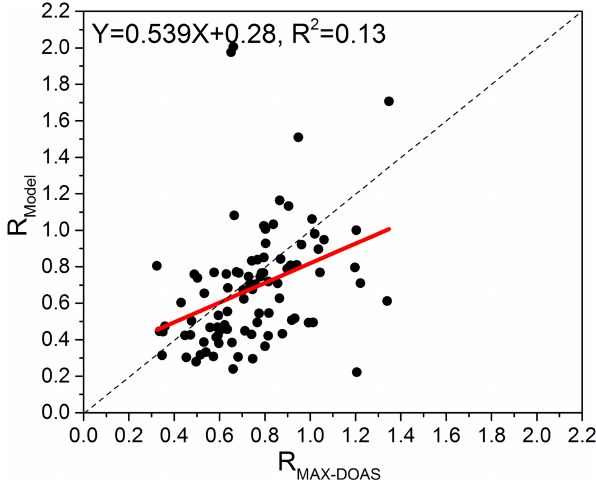
Figure 17. Scatter plots and linear regression of R Model against R MAX-DOAS (refer to the